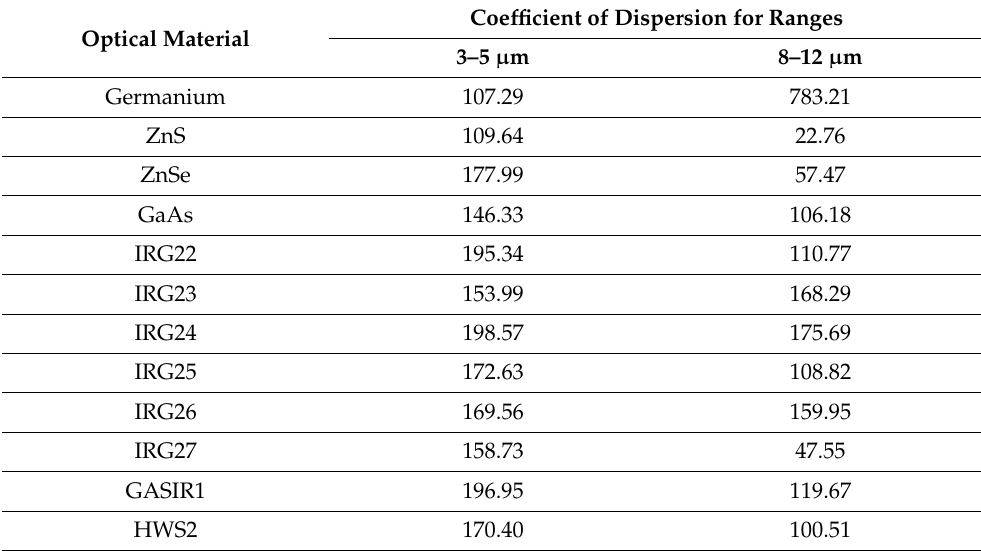
Table 1. Dispersion coefficients of several technological and commercially available IR materials calculated for the extreme and central wavelengths of the corresponding